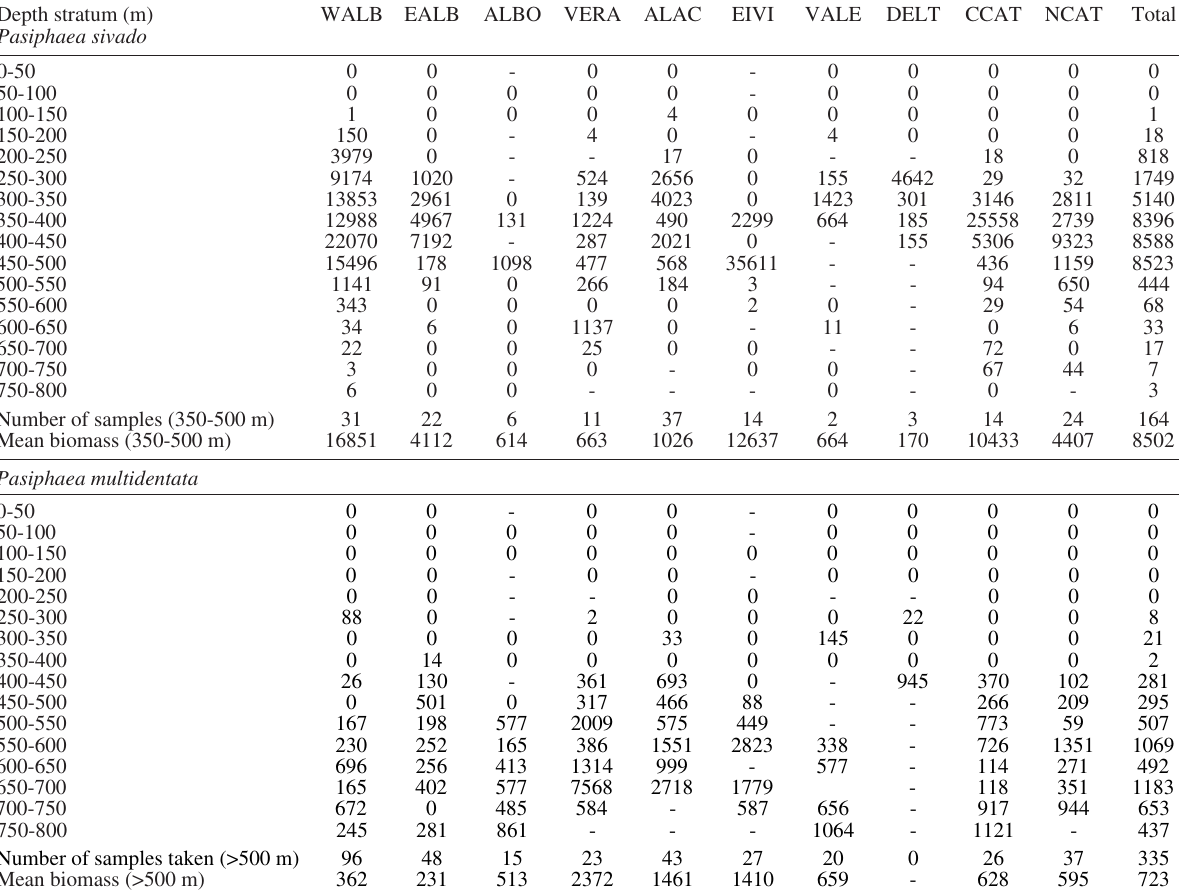
Table 3. – Mean biomass (g km –2 ) of Pasiphaea sivado and Pasiphaea multidentata within each depth stratum and geographic sector along the Iberian Peninsula Mediterranean coast. Mean biomass per geographic sector corresponds to values within the 350-500 m depth strata for P. sivado and >500 m for P. multidentata (i.e. those with the overall highest frequency of